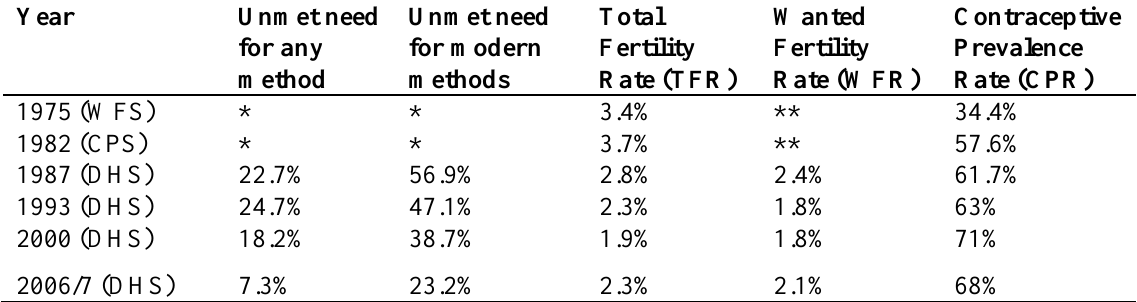
Table 1 - Levels of unmet need in relation to Contraceptive Prevalence Rate (CPR), Total Fertility Rate (TFR) and Wanted Fertility Rate (WFR)